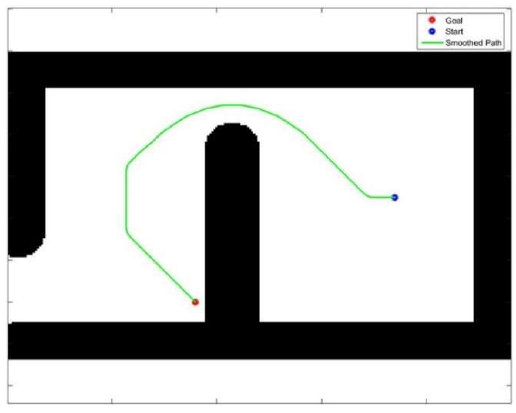
Figure 13. The generated path, for Dataset I, within the extension of the static obstacles.